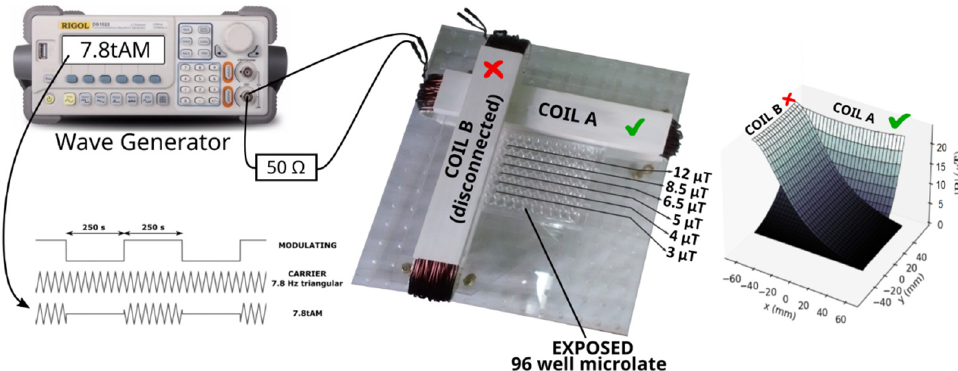
Figure 3. Scheme of the experimental set up. A 96-well microplate is exposed to a magnetic field generated by injecting a 7.8tAM waveform to one of the coils (COIL A) of the system of orthogonal coils. An oscilloscope (not shown in the picture) is hooked to a 50 Ω resistor connected in series with COIL A. The different rows of the microplate are exposed to different magnetic fields between 3 µT and 12 µT. To the right, a 3D representation of the fields that can be produced by the coils (in our experiments COIL B was disconnected, so no field was generated by it).